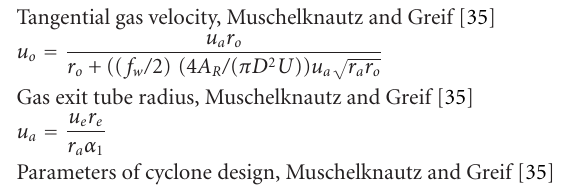
Table 3: Continued. Table 4: Hydrodynamic and thermal models for the two-fluid gas- solid flow